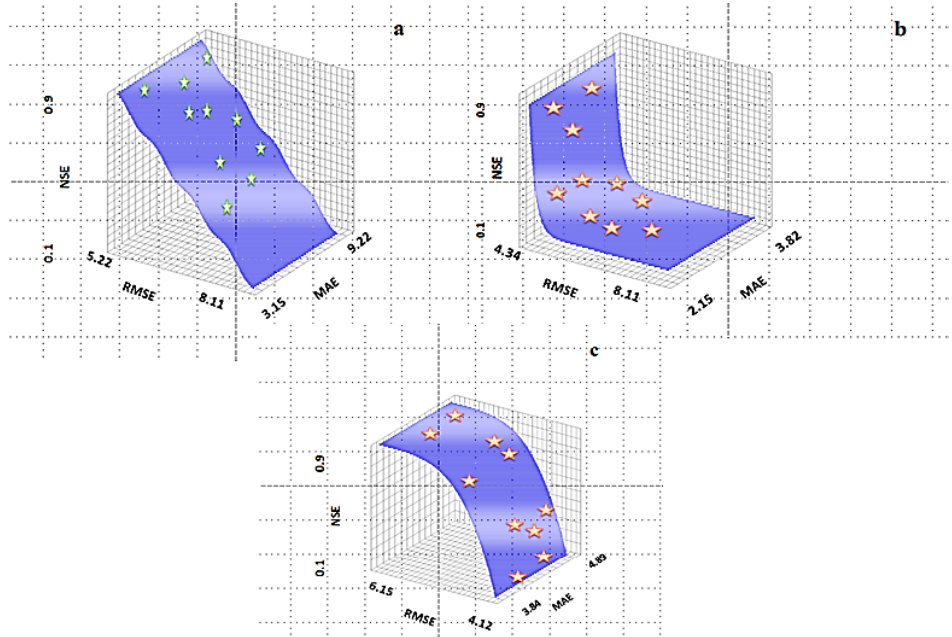
Figure 8. The tree generated three dimensional figure based on all solutions in Pareto with the determination of 10 points of the Pareto solution in the ANFIS-MOSA model for ( a ) the test level in EAZP, ( b ) test level in AP, and ( c ) test level in GP. Table 6. Consideration of ANFIS and MOSA model with and without AQI for the best solution.